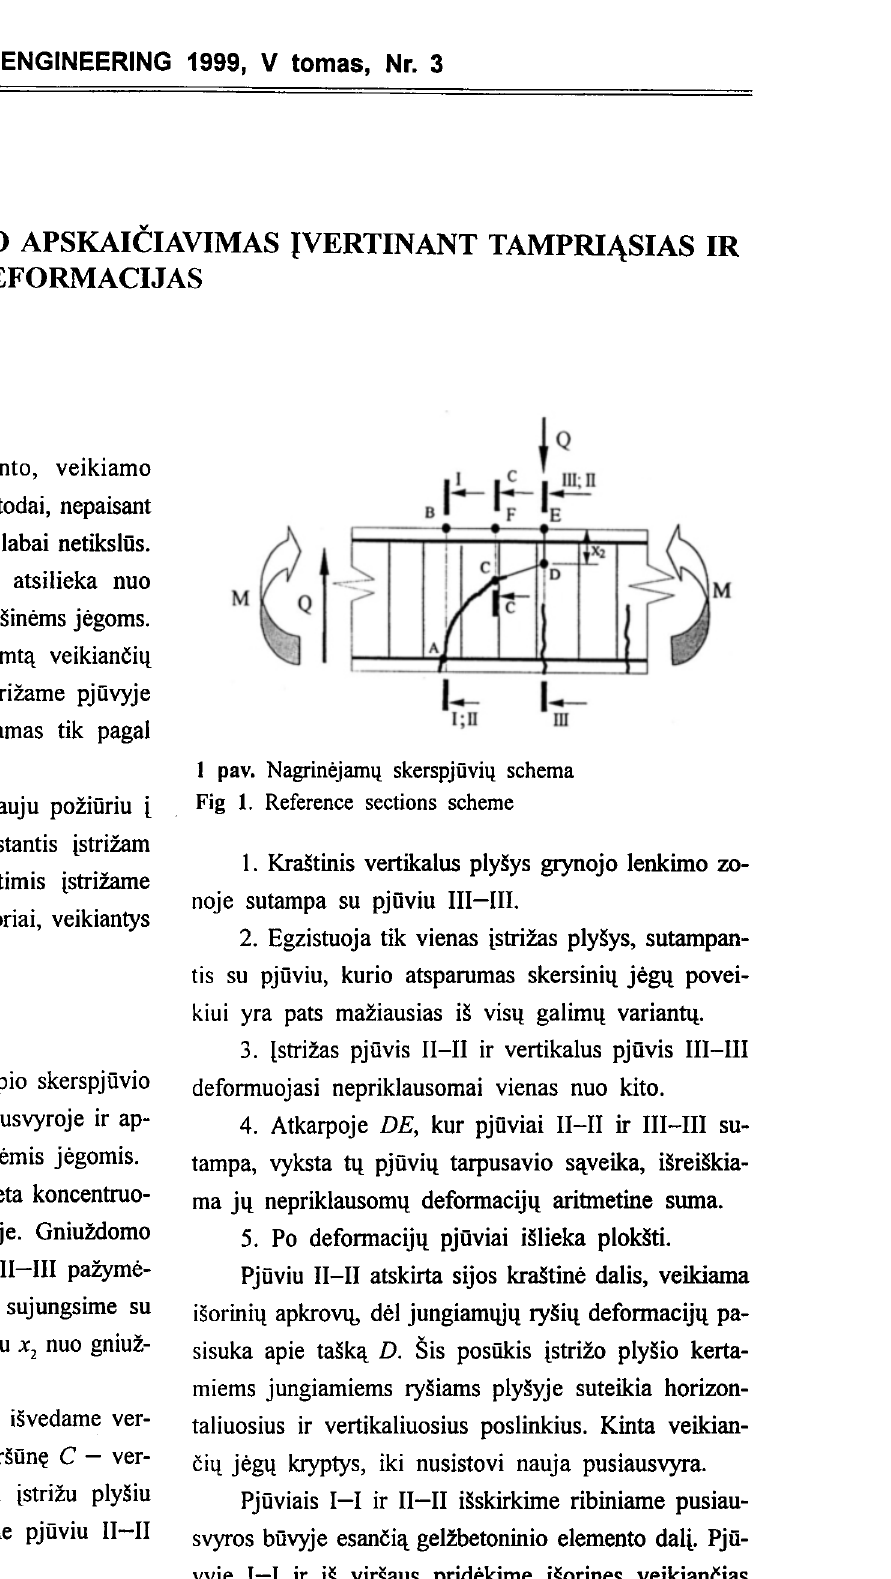
Fig 1. Reference sections